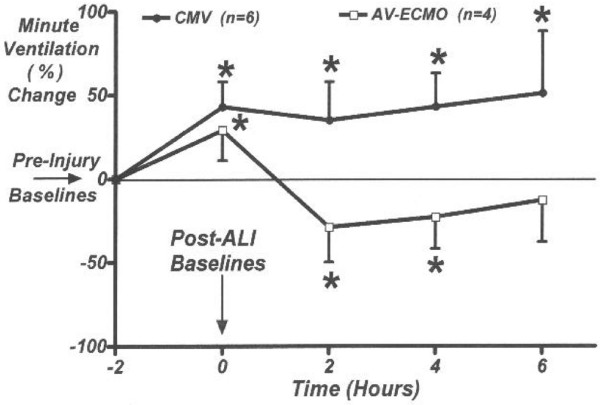
Comparisons between the minute ventilations (calculated per kg body weight) required to maintain normocapnia in lung-injured lambs subjected to conventional mechanical ventilation (CMV) or arteriovenous (AV)-extracorporeal membrane oxygenation (ECMO) with shunt flow of 15% of baseline cardiac output. Analysis of variance (ANOVA) followed by Dunnett multiple comparisons test was used to compare the preinjury level of minute ventilation in each group with subsequent measurements. ANOVA followed by Bonferroni test was used to compare CMV and AV-ECMO therapies at different time periods during the study period. Values are expressed as mean ± standard deviation. *P < 0.05. ALI, acute lung injury.